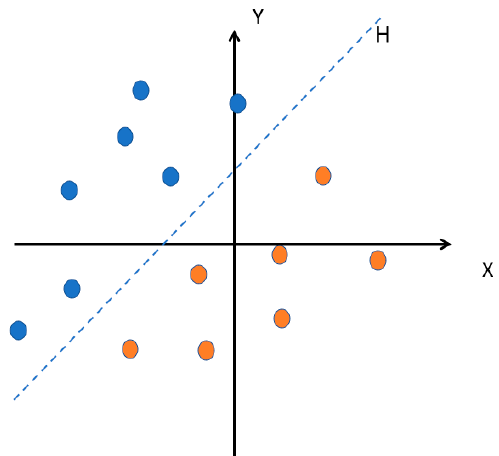
Figure 2. The hyperplane H, that separates the two groups of points.